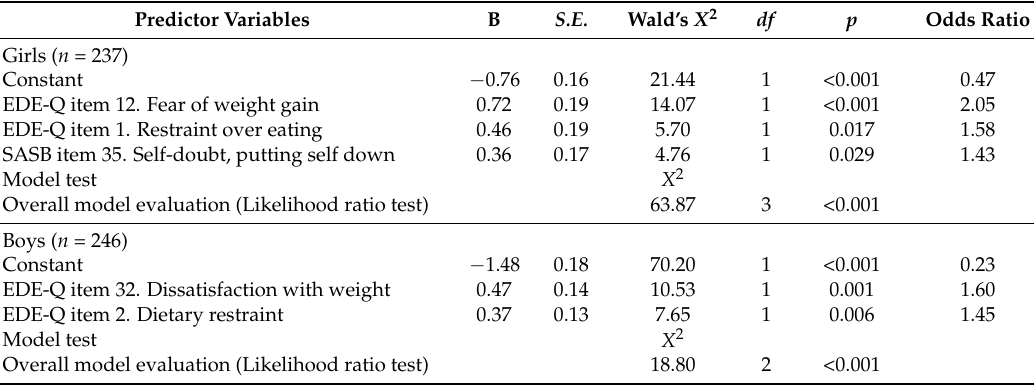
Table 2. Logistic regression analysis of EDE-Q and SASB items in relation to compulsive exercise, with independent variables standardized to simplify interpretation due to the different scales in EDE-Q and SASB, listed in order of prediction strength. Coefficients and model tests from final stepwise